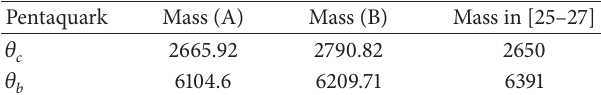
Table 2: Hadronic molecular structure of pentaquarks. Hadronic structure